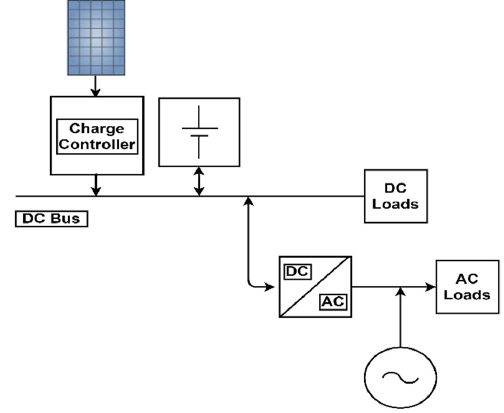
Figure 1. DC-PV system.